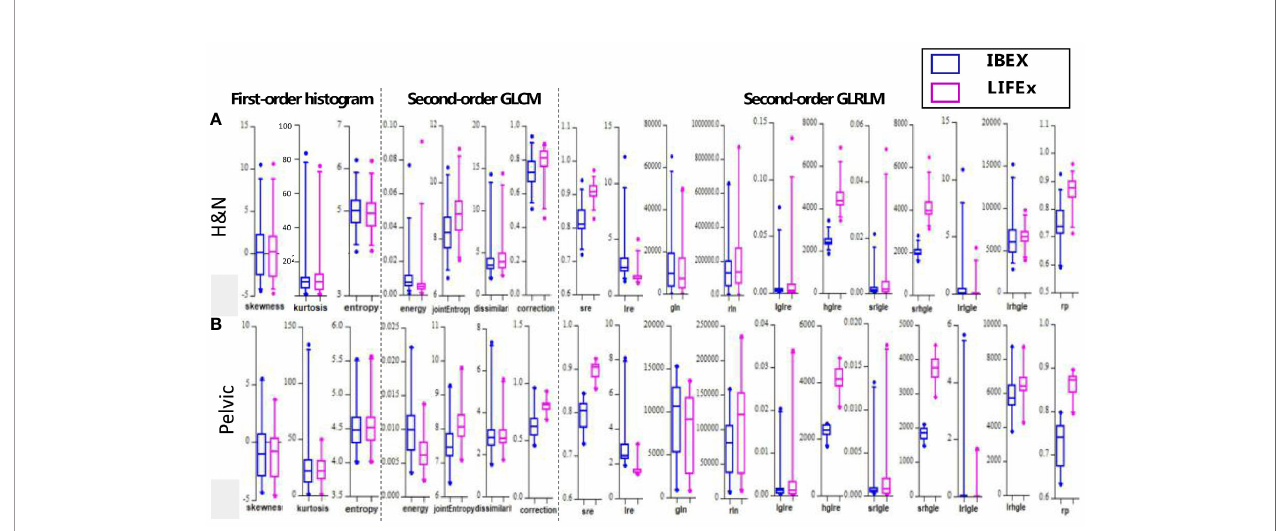
FIGURE 3 | The boxplots showing all values of the features analyzed by the two different softwares for (A) H&N and (B) pelvic sites, respectively.